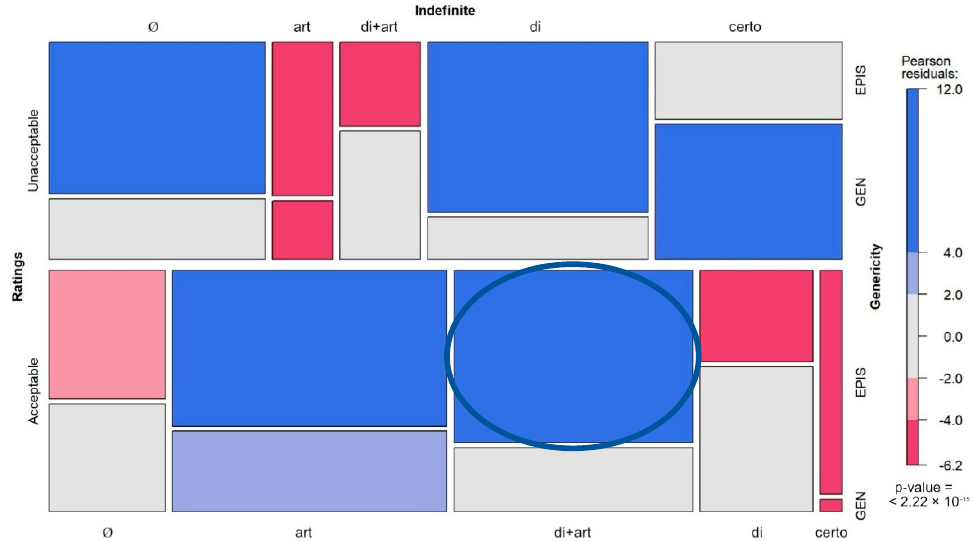
Figure 7. (Un)acceptability rate of each indefinite determiner with episodic and generic sentences. The blue circle highlights the greater acceptability for di +art in episodic sentences.